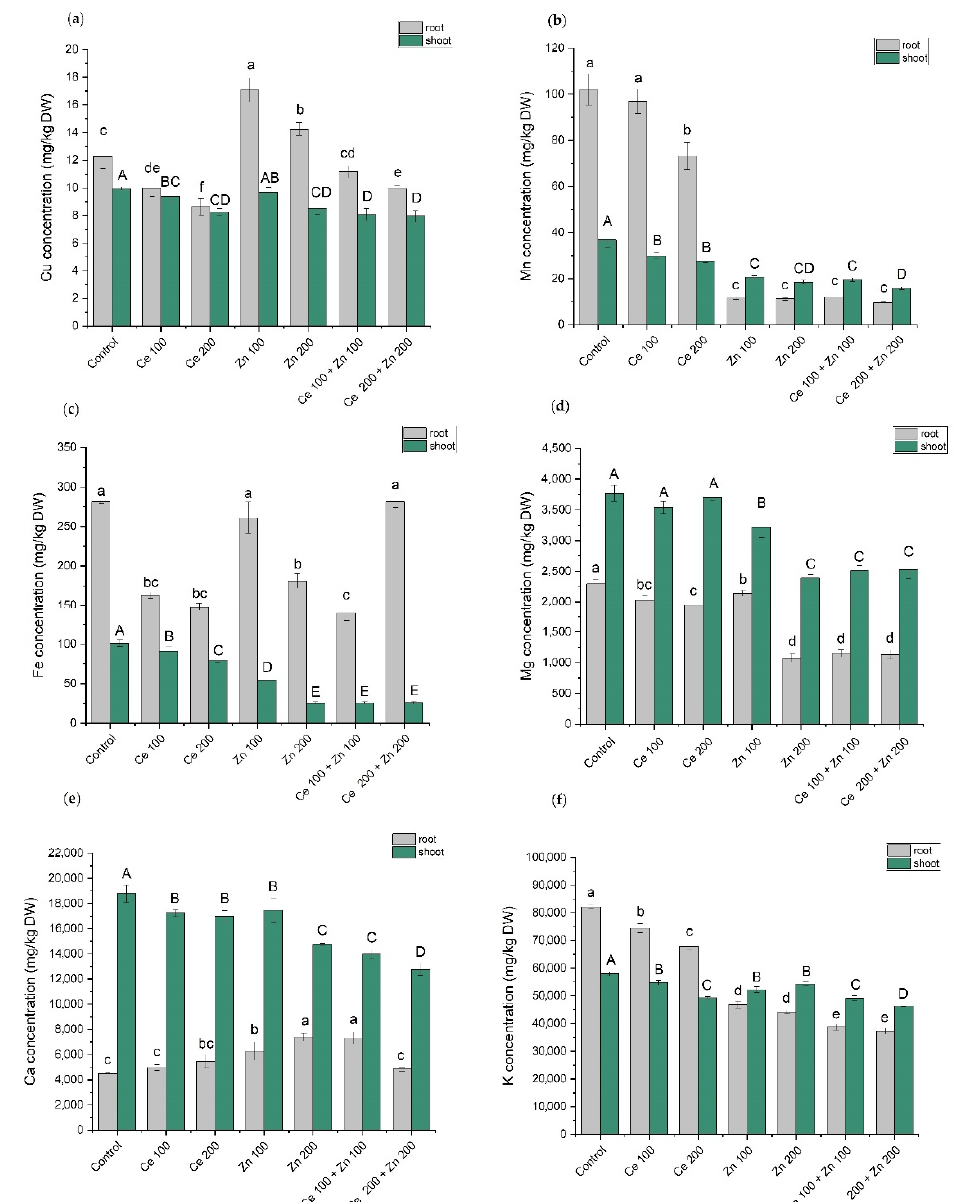
Figure 5. Copper ( a ), manganese ( b ), iron ( c ), magnesium ( d ), calcium ( e ), and potassium ( f )concentrations in roots and shoots of Pisum sativum L. grown under the sole or combined CeO 2 and ZnO NPs treatment. Concentrations of nanoparticles are given in mg/L of elemental cerium and zinc, respectively. The cultivation time was 12 days. Vertical bars represent standard deviations ( n = 6). Distinct letters show the statistically significant differences among treatments as calculated with Tukey’s HSD post hoc test ( p = 0.95).